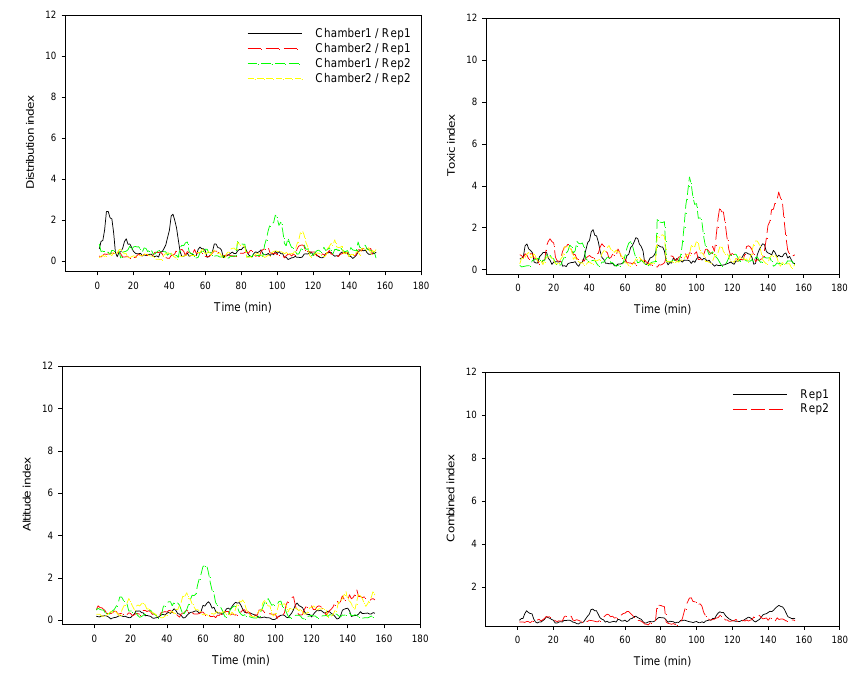
Figure 3. Results of indexes (DI, TI, AI, and CI) in normal condition. The Rep# refers replication number of test.